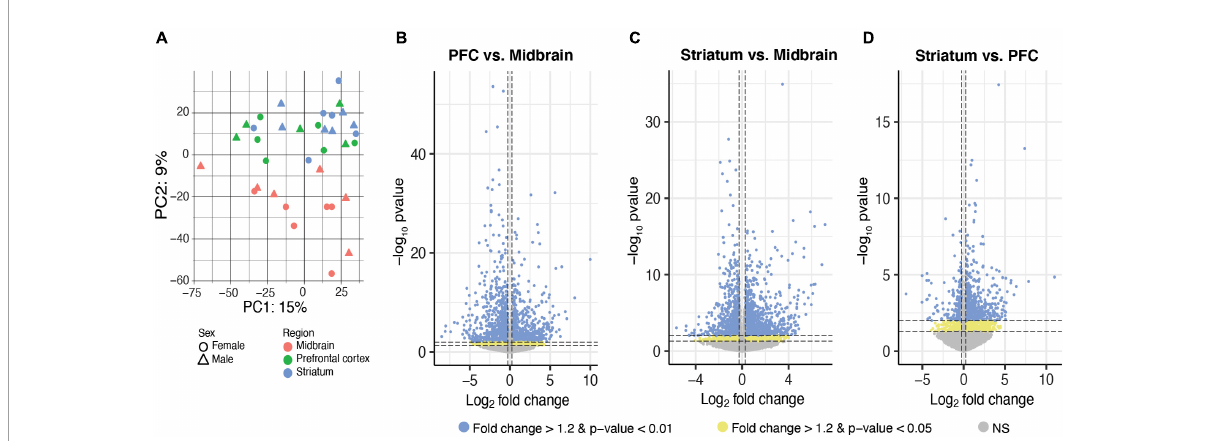
FIGURE2 Differential expression of microglia-specific transcripts across brain regions. (A) Principal component (PC) analysis indicated distinct transcriptional profile in midbrain-isolated microglia compared to prefrontal cortex (PFC) and striatum. Log 2 FoldChange plotted relative to –log 10 pvalue by volcano plots for differentially expressed transcripts between PFC and midbrain (B) , striatum and midbrain (C) , and striatum and PFC (D) . Horizontal dashed lines represent p-value significance cutoffs of p < 0.01 and p < 0.05, while vertical dashed lines represent log 2 FC cutoffs of ≤ –0.26 or ≥ 0.26 (FC ≥ 1.2). Blue dots represent DE transcripts with p < 0.01 and FC ≥ 1.2. Yellow dots represent DE transcripts with p < 0.05 and FC ≥